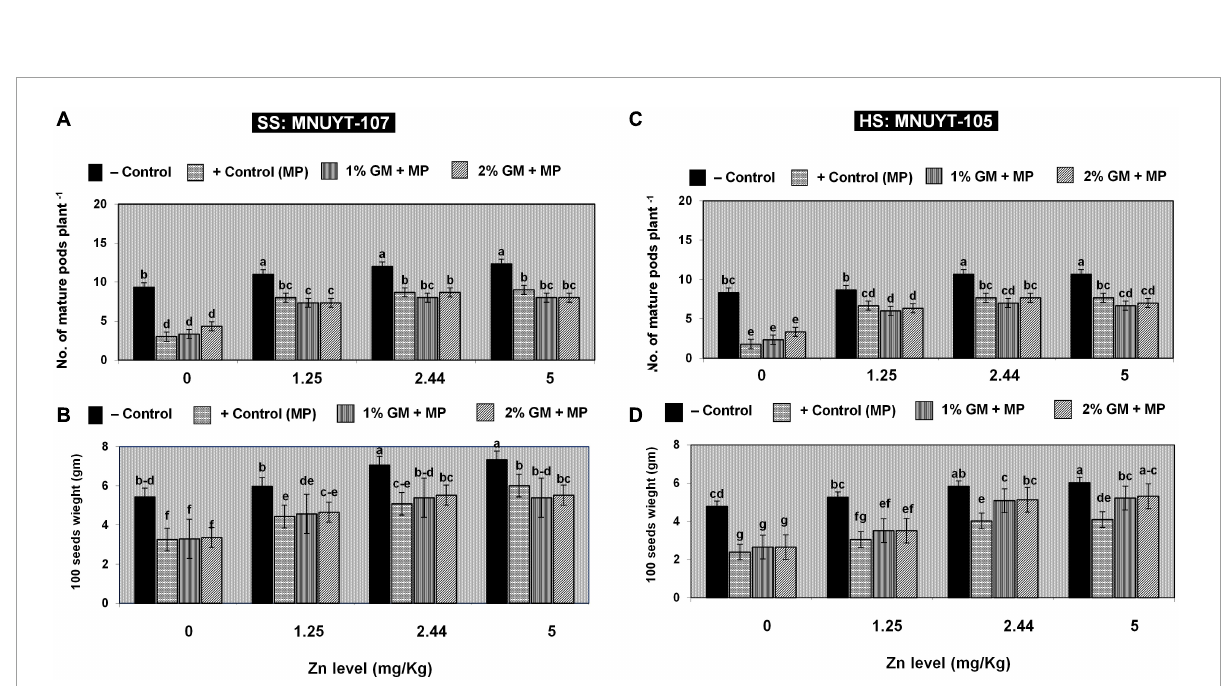
FIGURE3 (A–D) Effect of soil application with zinc (Zn) and green manure (GM) on reproductive attributes in susceptible (SS: MNUYT-107) and highly susceptible (HS: MNUYT-105) genotypes of mungbean after 70 days of sowing. –ve control (without pathogen, Zn or GM); +ve control [ M. phaseolina (MP)]. Vertical bars show standard errors of means of three replicates. Means with the same letters are not significantly different at p < 0.05 according to Fisher’s least significant difference (LSD)